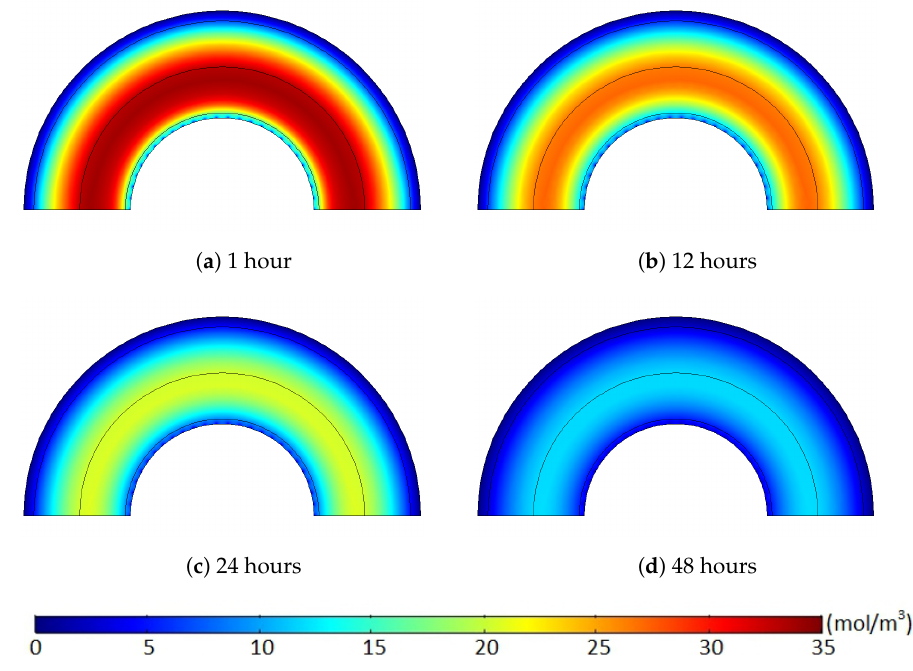
Figure 15. Methane concentration (mol/m 3 ) over time where the initial methane concentration is nonuniform. The degassing temperature is 343.15 K and C l = 1/90. ( a ) 1 hours, ( b ) 12 hours, ( c ) 24 hours, ( d ) 48